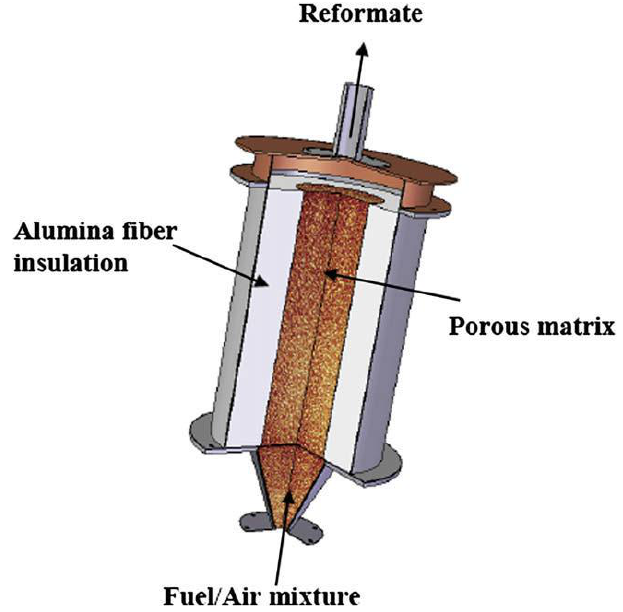
Figure 6. Reformer based on the partial oxidation of methane to hydrogen in a thermal porous matrix [79] (copyright with permission from [79], Elsevier, 2008).